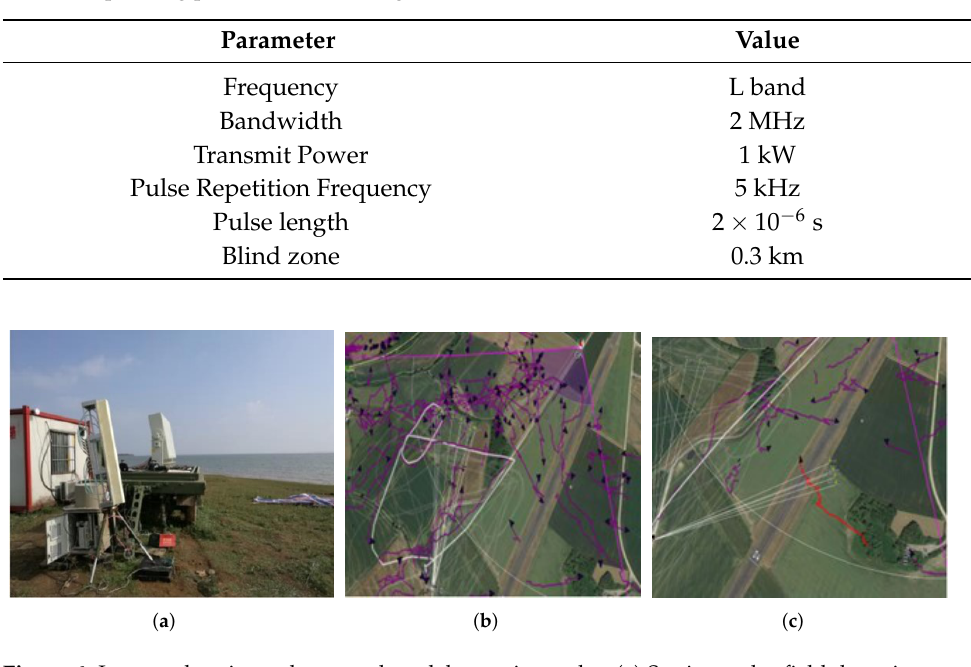
Figure 6. Images showing a detect and track by staring radar. ( a ) Staring radar field detection scene. ( b ) UAV trajectory (white). ( c ) A bird trajectory